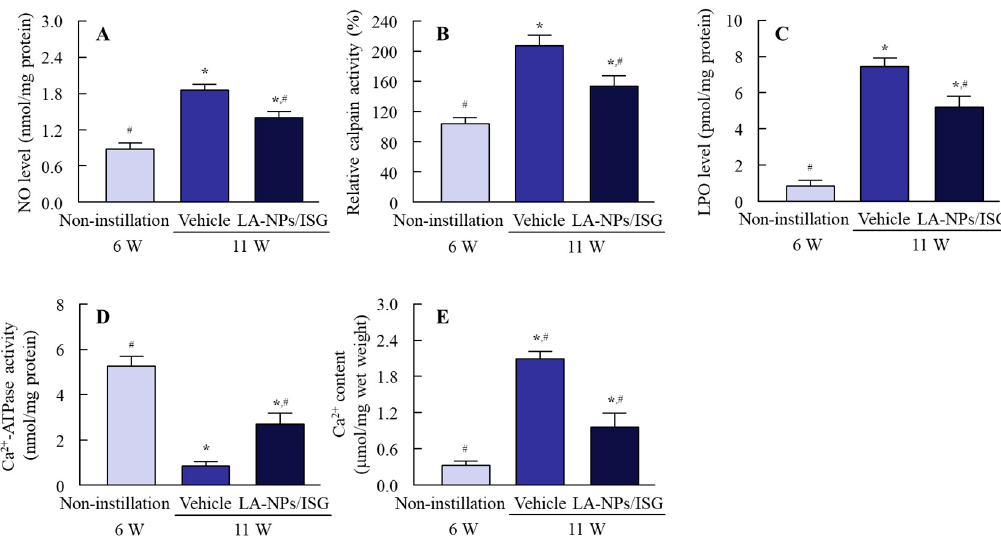
Figure 7. Changes in NO levels ( A ), calpain activity ( B ), lipid peroxidation (LPO) levels ( C ), Ca 2 + -ATPase activity ( D ), and Ca 2 + content ( E ) in the lenses of 11-week-old SCR-C repetitively instilled with LA-NPs / ISG. The repetitive instillations were performed twice per day from six weeks of age. Non-injection, non-instilled SCR-C aged 6 weeks. Vehicle, Vehicle-instilled SCR-C aged 11 weeks. LA-NPs / ISG, LA-NPs / ISG instilled SCR-C aged 11 weeks. Vehicle is solution consisting of BAC, mannitol, HPCD, and MC. n = 6–13. * p < 0.05, vs. Non-instillation for each group. # p < 0.05, vs. vehicle for each group. The repetitive instillation of LA-NPs / ISG attenuated the changes in cataract-related factors (enhancement of NO levels, calpain activity, LPO levels, and Ca 2 + content, and decrease of Ca 2 + -ATPase activity) in the lenses of SCR-C.